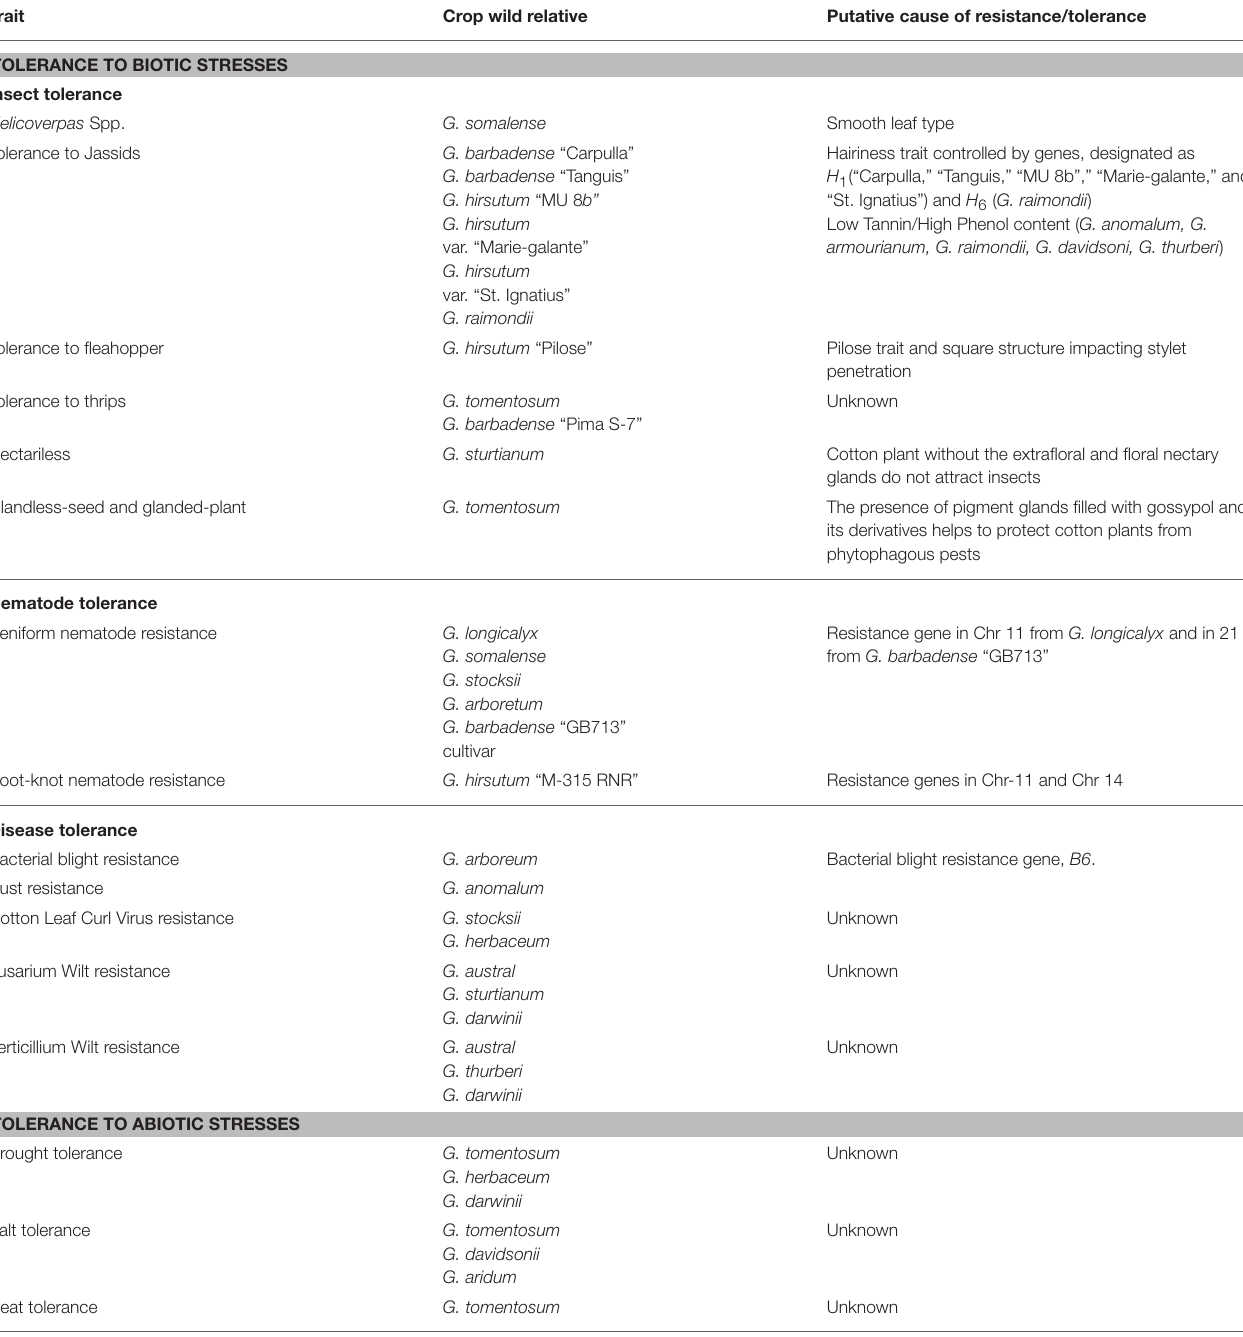
TABLE 3 | Summary of biotic and abiotic stress tolerance traits of wild relatives of cultivated cotton species. Trait Crop wild relative Putative cause of resistance/tolerance TOLERANCE TO BIOTIC STRESSES Insect tolerance Helicoverpas